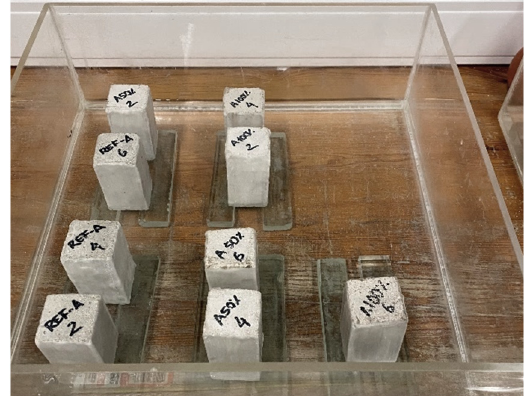
Figure 5. Water absorption by capillarity test